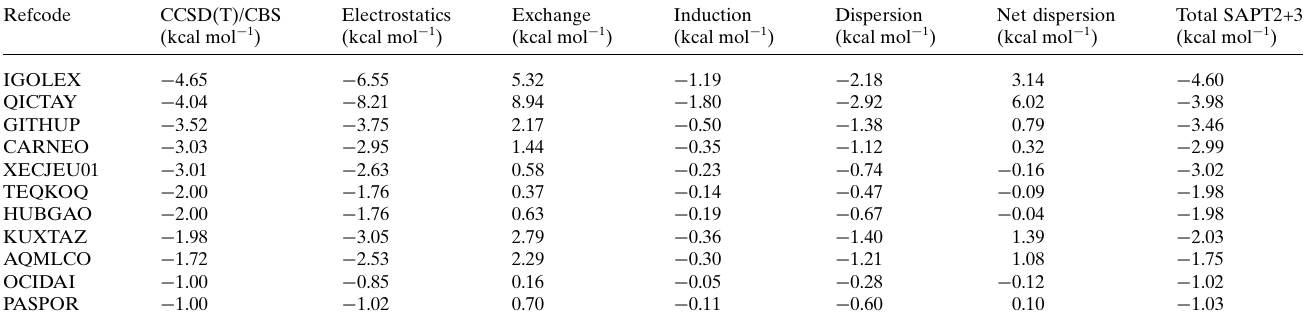
Table 1 Results of the SAPTanalysis on some of the geometries of water–water contacts belonging to the group of antiparallel interactions ( (cid:3) 1 , (cid:3) 2 (cid:3) 160 (cid:4) , 80 (cid:4) (cid:2) (cid:2) (cid:2) 140 (cid:4) and T HOHO > 40 (cid:4)